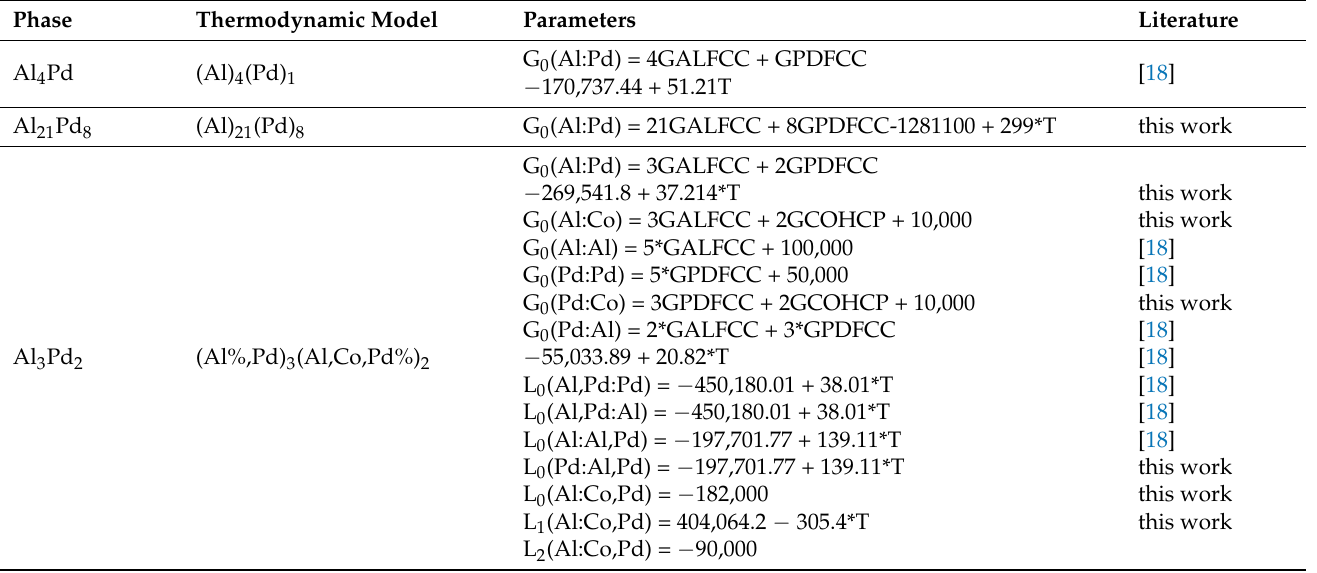
Table 3. Thermodynamic parameters of the Al–Pd